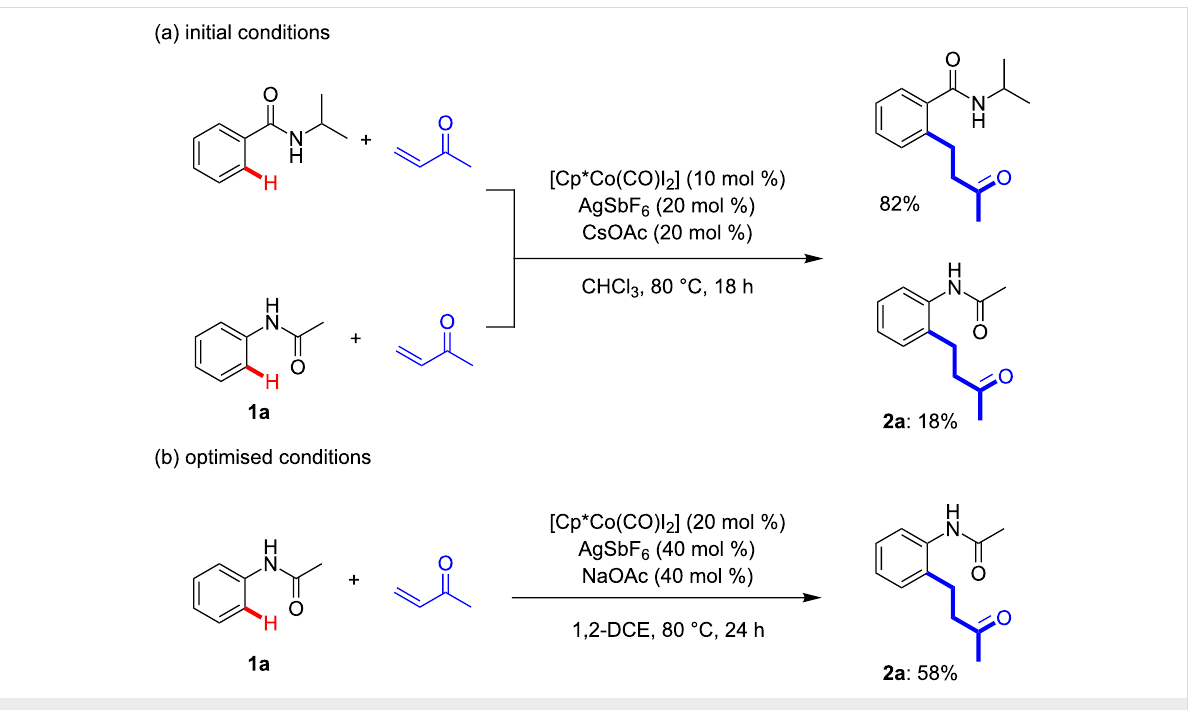
Scheme 2: Summary of reaction conditions